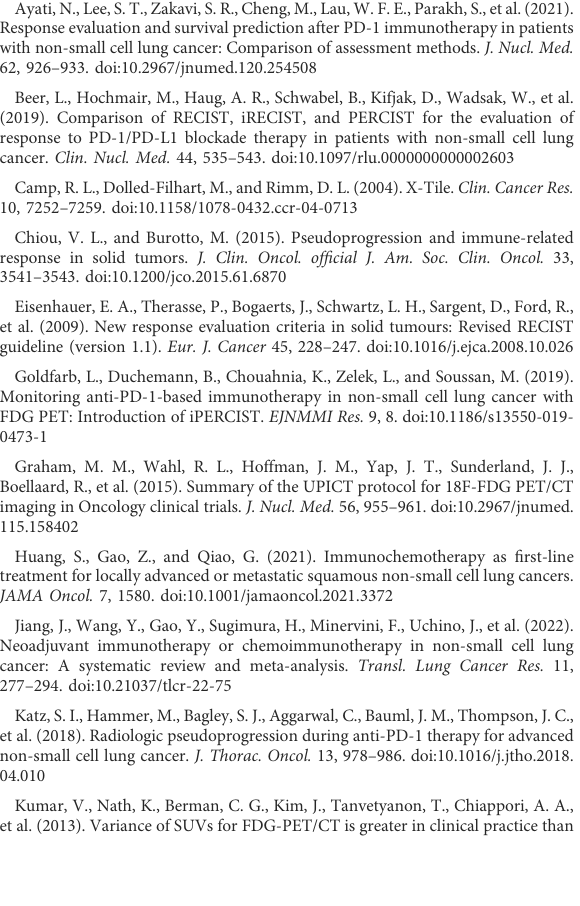
SUPPLEMENTARY FIGURE S1 Paired sample test for PET-associated metabolic characteristics. (A) SULmax. (B) SULpeak; (C) SULmean; (D) MTV; (E) TLG; (F) size. Blue dots represent patients at baseline PET-CT evaluation, while red dots represents patients at the fi nal time of tumor response evaluation. *, p < 0.05; **, p < 0.01, ***, p < 0.001. MTV, metabolic tumor volume; TLG, total lesion glycolysis; PreT: pretreatment; PostT: posttreatment. SUPPLEMENTARY FIGURE S2 Receiver-operating-characteristics (ROC) analysis for assessment of iRECIST, iPERCIST and iPERCIST-max in predicting major pathological response status. (A) iRECIST; (B) iPERCIST; (C)